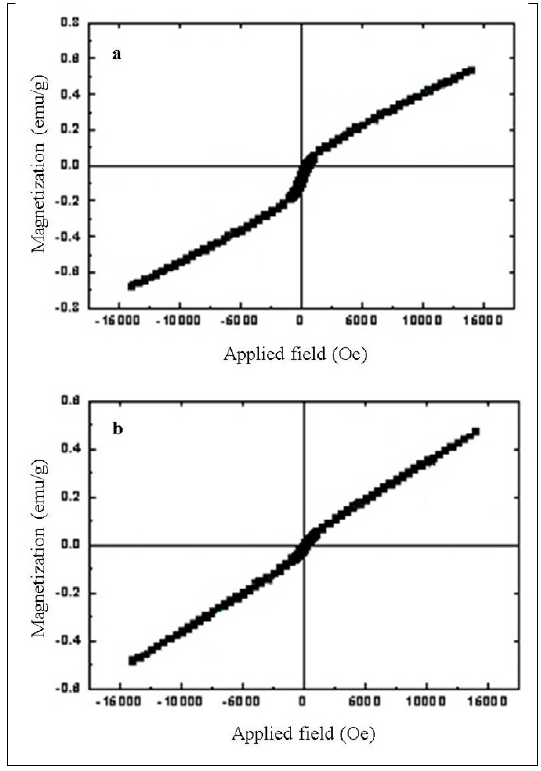
Fig. 6. VSM of the as-prepared Cr 2 O 3 nanoparticles at a) 500 ºC and b) 600 ºC